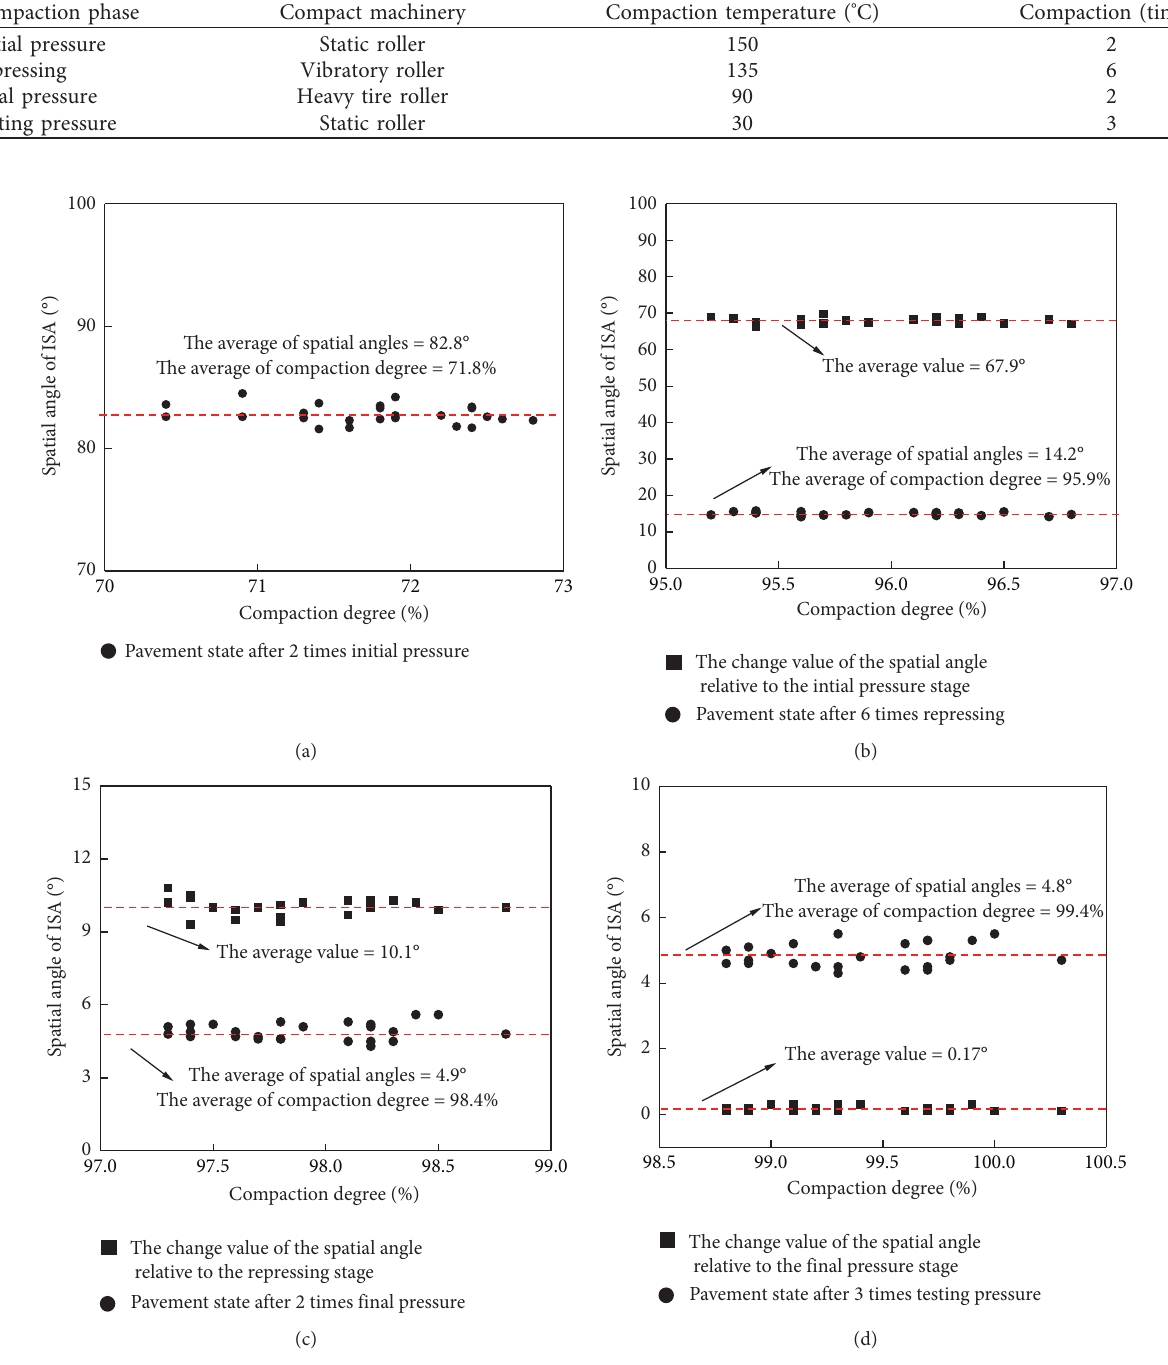
Figure 12: The relationship between the ISA spatial angle and the compaction degree. (a) Initial pressure. (b) Repressing. (c) Final pressure. (d) Testing